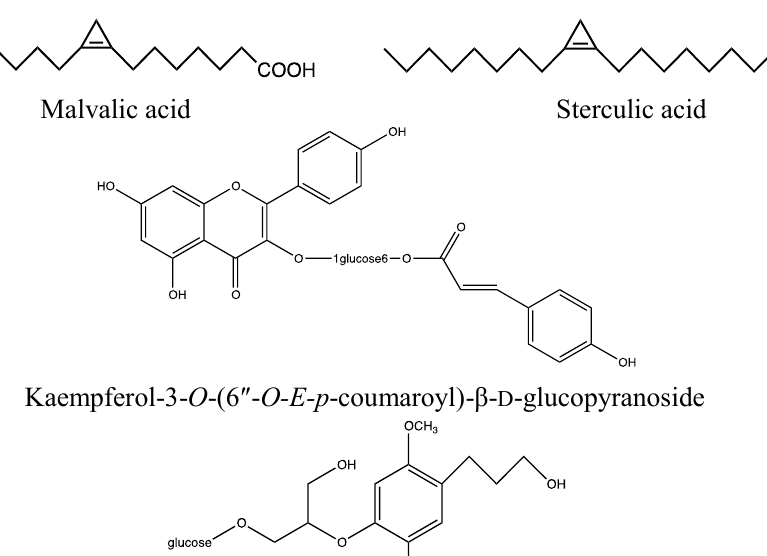
Figure 4. Fatty acids and phenolic constituents of Heritiera littoralis leaves and